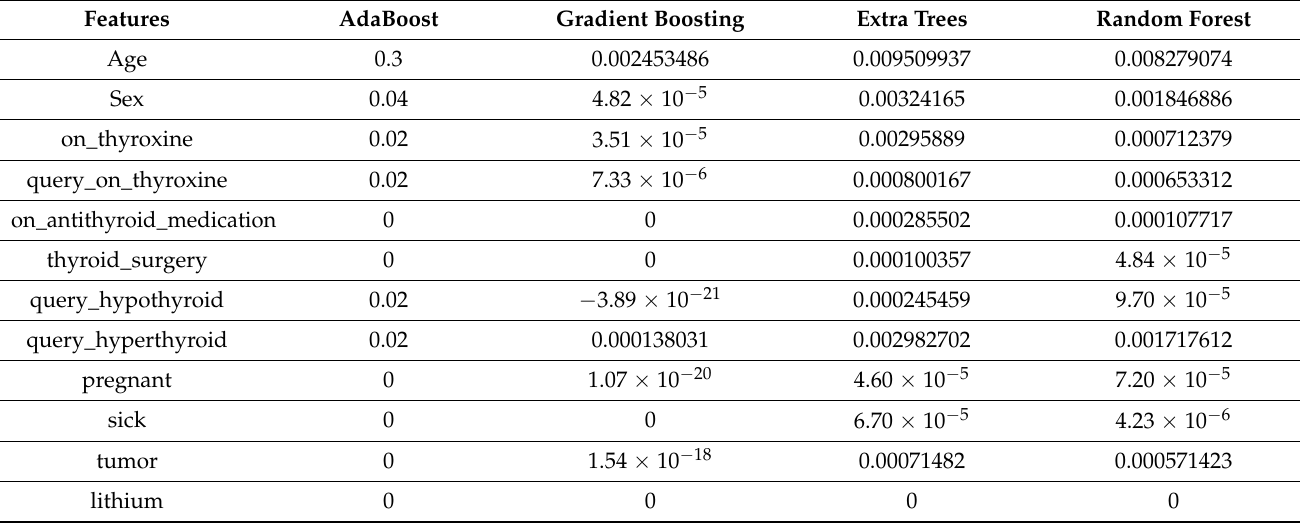
Table 7. Classifier feature importance values of each feature after feature